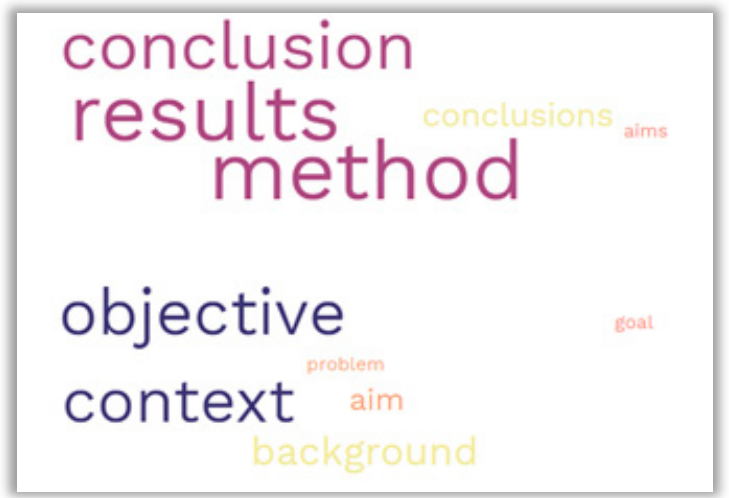
Figure 4. Word cloud summarizing the structure of abstracts.